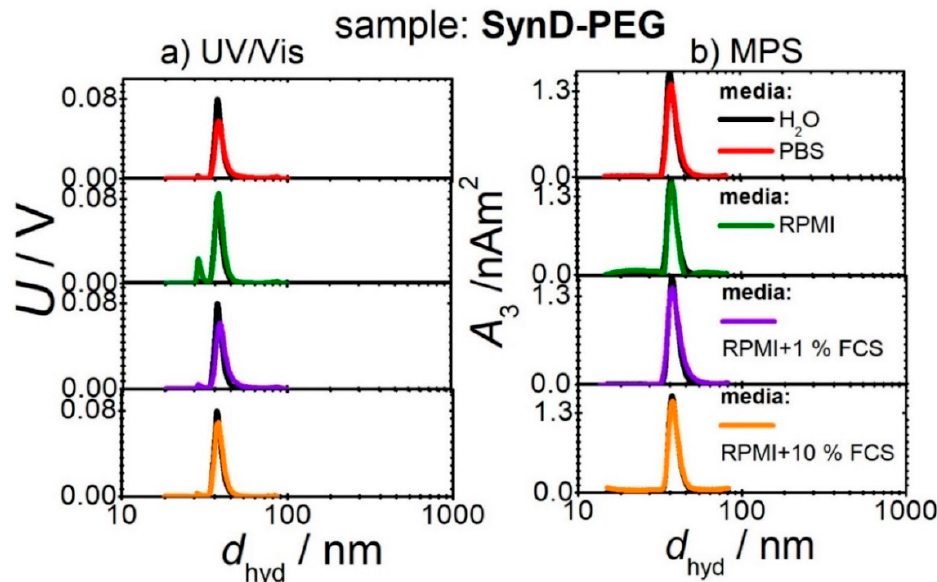
Figure 2. Iron concentration ( c (Fe)) (obtained from ( a ) UV/Vis) and magnetic amplitude ( A 3 ) (measured by ( b ) MPS) as a function of hydrodynamic diameter ( d hyd ) obtained (by DLS) during CF3 separations of SynD-PEG in four different media.